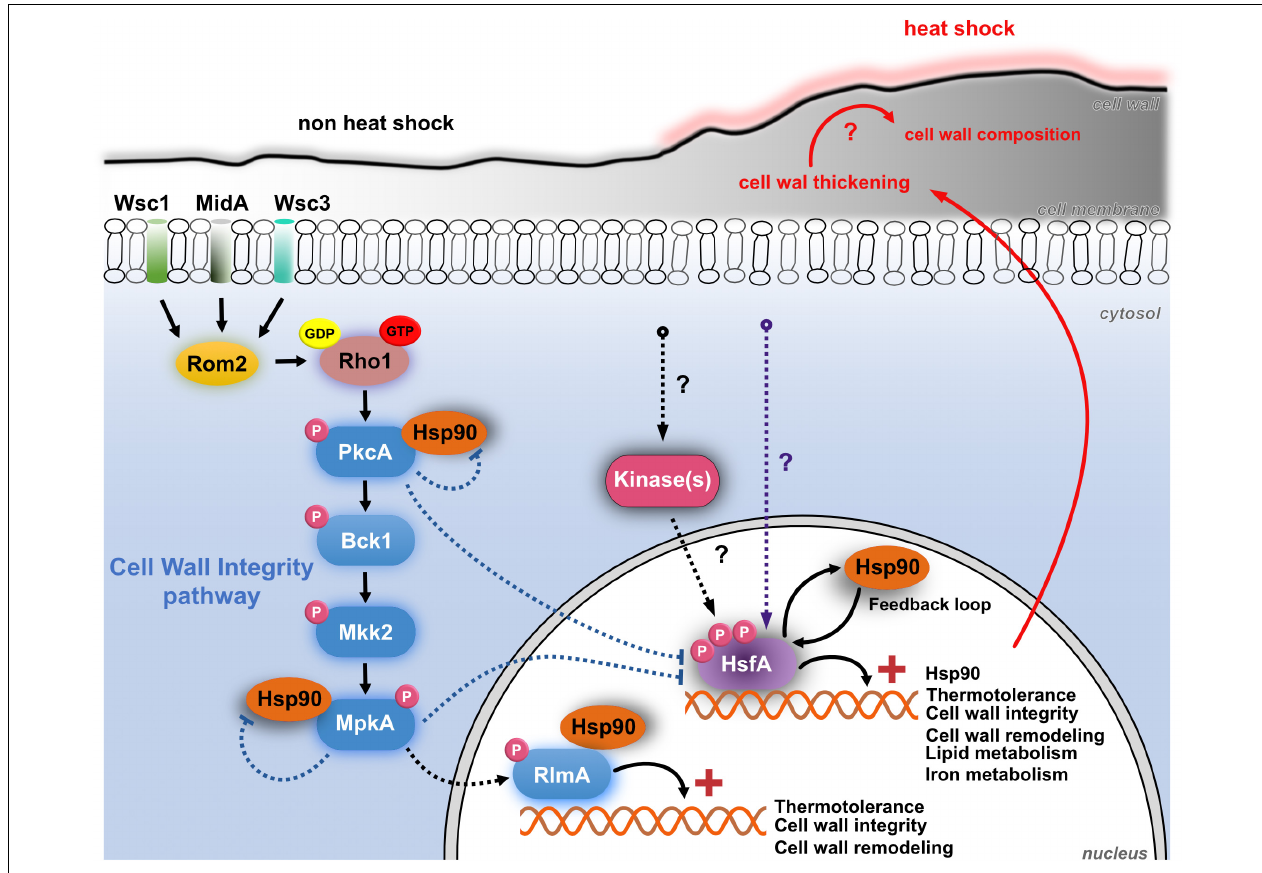
FIGURE 10 | The crosstalk between HsfA-Hsp90 and CWI pathway in A. fumigatus during HS. The CWI pathway is activated during early adaptation to HS, possibly via MidA mechanosensor located at the cell membrane. This signal funnels into Rom2, a guanine nucleotide exchange factor, and the small Rho GTPAse Rho1, leading to the activation of PkcA and the CWI pathway. These events culminate with the phosphorylation of the MAP kinase MpkA, which, in turn, phosphorylates the transcription factor RlmA, thus activating the transcription of genes ( + ) important for thermotolerance, cell wall integrity, and remodeling. The CWI pathway proteins PkcA, MpkA, and RlmA are constitutive Hsp90 clients. A direct consequence of the HS is the thickening of the cell wall after 5 min of temperature increase, which may have consequences to the remodeling of the cell wall and exposure of carbohydrate to the cell surface. However, these consequences remain to be investigated (red question marks). Also, the cellular plasma membrane becomes more fluid in response to thermal insult. Although not necessary for HsfA activation, PkcA and MpkA negatively regulate the expression of HsfA and Hsp90, both during the HS (dashed blue arrows) and upon cell wall stress induced by caspofungin (not shown in the Figure; see text for details). The resulting increase in protein abundance of HsfA and Hsp90 in the pkcA and mpkA mutants possibly occurs via undescribed compensatory mechanisms accompanied by the activation of additional signaling cascades to retain the CWI and thermotolerance (purple dashed line). In the face of heat stress, mRNA abundance of HsfA increases and triggers the expression of genes related to thermotolerance, cell wall integrity, cell wall remodeling, lipid, and iron metabolism. One of its transcriptional targets, Hsp90, is also induced to deal with HS and assist the stabilization of client proteins. After about 15–30 min of HS, the HsfA levels decrease, possibly due to the action of Hsp90 in the regulatory feedback loop. This regulatory mechanism comprises the Hsf1/Hsp90 protein–protein interaction (not investigated here), which is reversed during the HS, when Hsp90 protein levels increase and decouple from Hsf1 to assist the folding of client proteins. The activity of Hsf1 remains until Hsp90 again binds to Hsf1, negatively regulating Hsf1 (see text for details). Hyperphosphorylation (not investigated here) is another regulatory event that modulates the transcriptional activity of HsfA orthologs in other fungal pathogens. The protein(s) kinase(s) responsible for HsfA phosphorylation are still unknown in A. fumigatus . This diagram is based on data from this article and the references (Dichtl et al., 2012; Leach et al., 2012b; Rocha et al.,